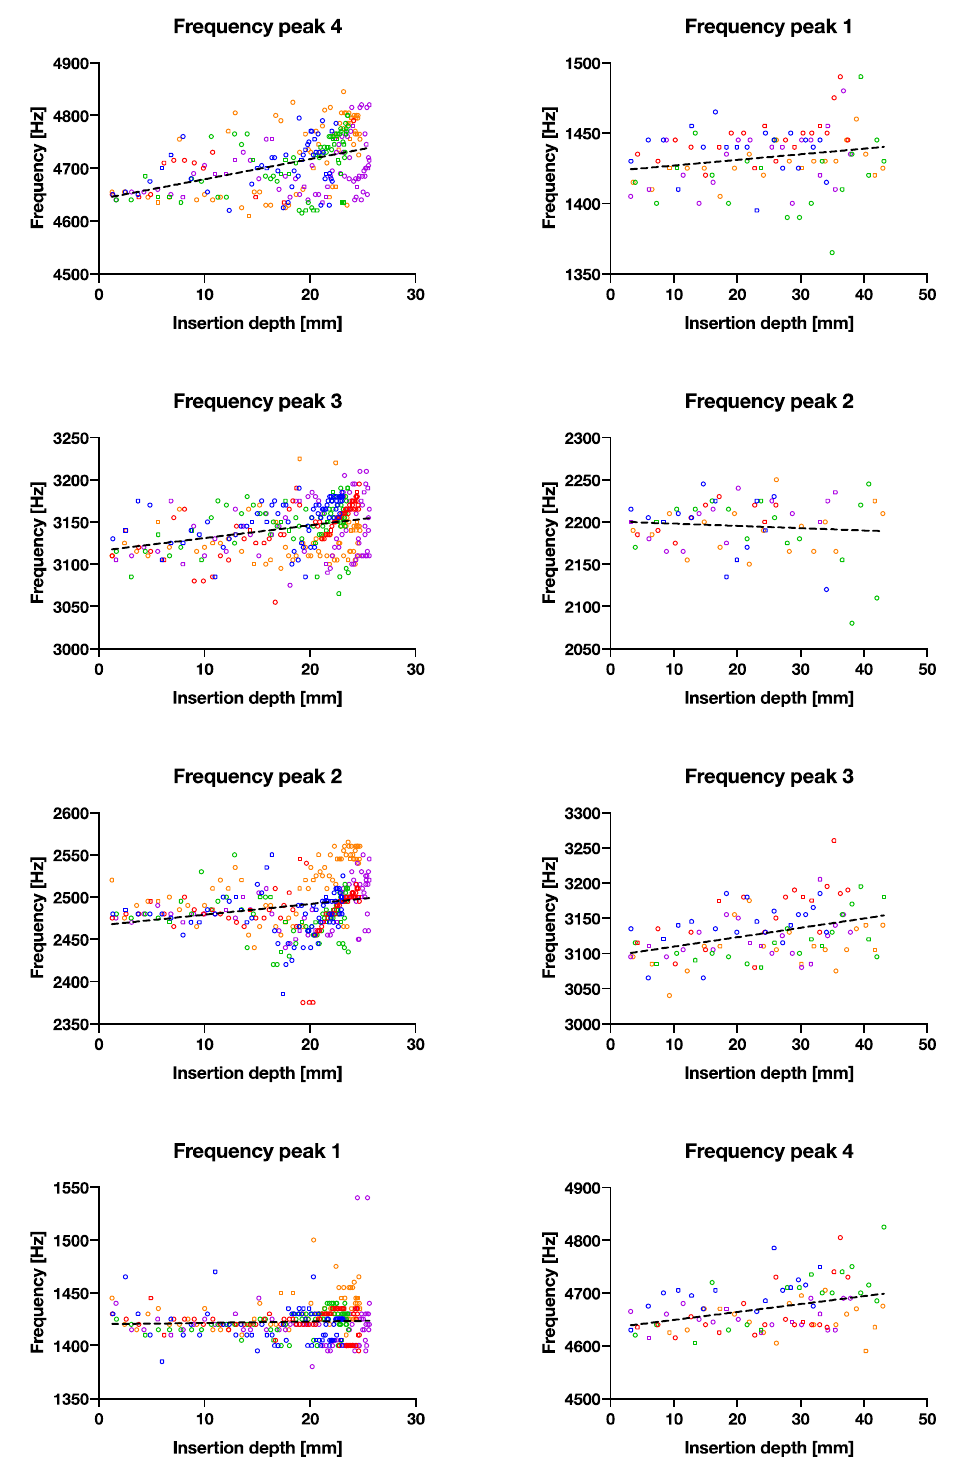
Figure 7. The correlation between recorded frequency vs. broach insertion depth with linear trend lines. Left column shows the larger broach with good fixation and right column shows the smaller broach with poor fixation. Each row represents the four main frequency peaks observed.